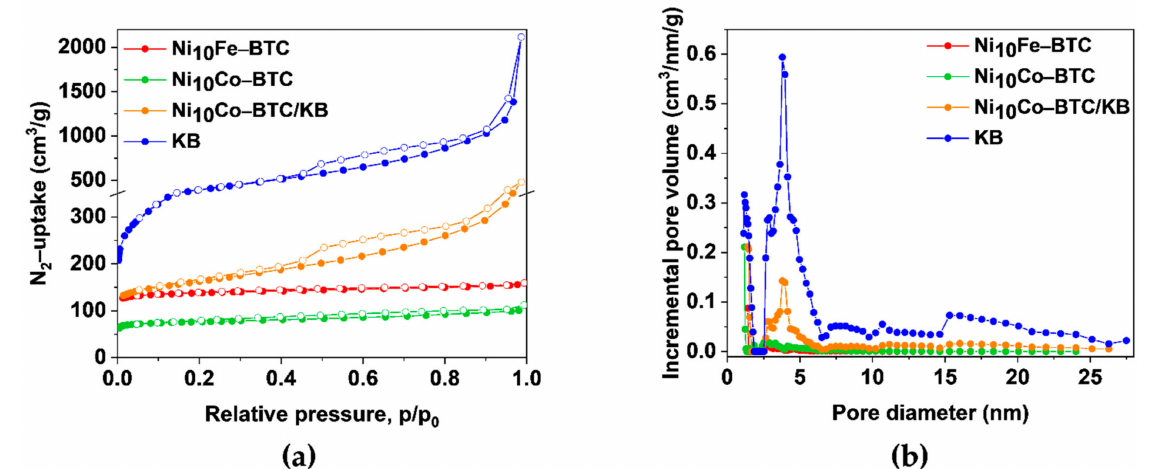
Figure 3. ( a ) N 2 -sorption isotherms at 77 K (Adsorption: filled circles; desorption: empty circles), ( b ) pore size distributions of Ni 10 Fe-BTC (red), Ni 10 Co-BTC (green), Ni 10 Co-BTC/KB (orange) and KB